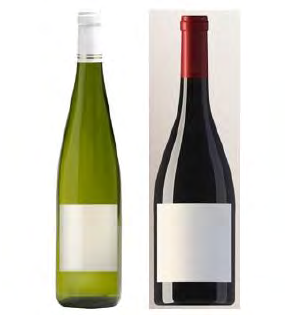
Figure 7. The shapes of a traditional wine bottle from Alsace (left) and Bourgogne